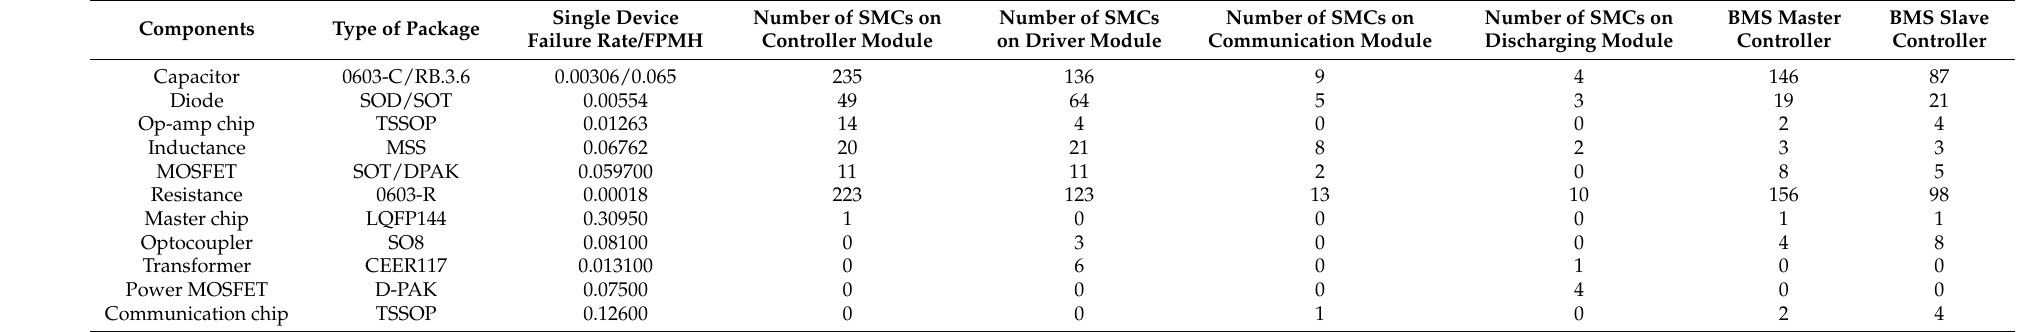
Table A3. Type, failure rates, and number of SMCs on